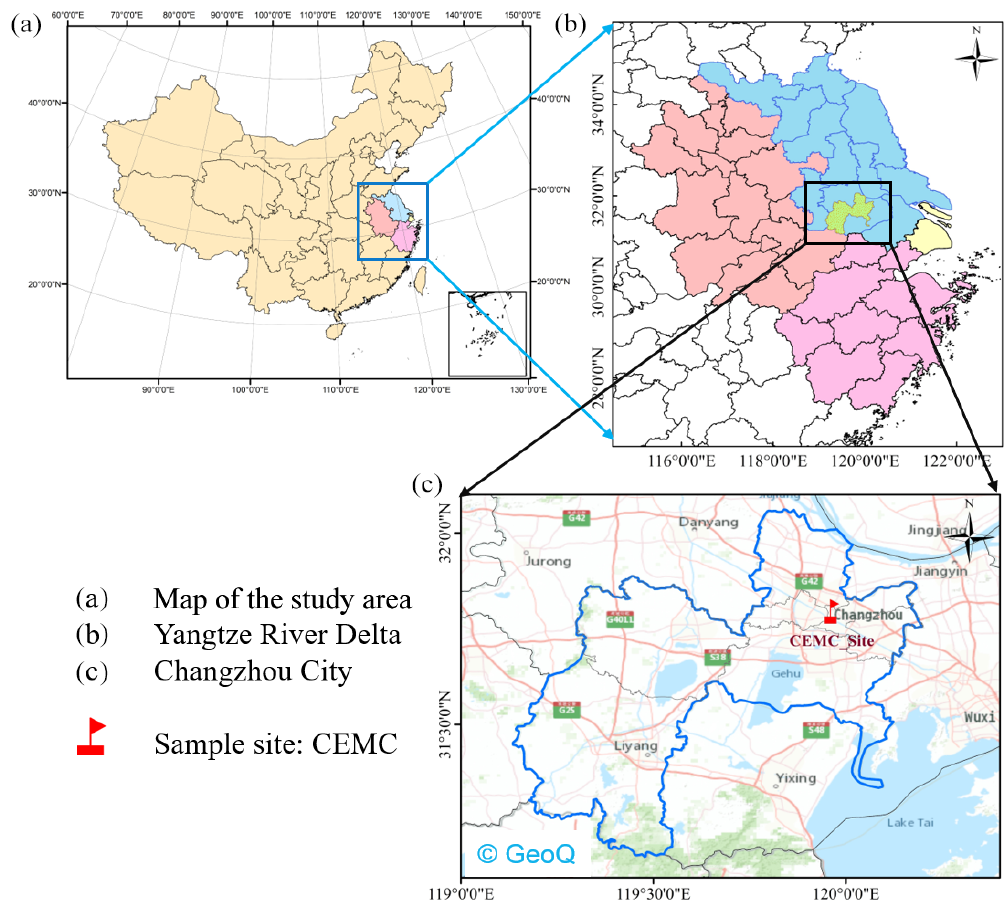
Figure 1. Location of the sampling site in Changzhou, China. Table 1. Statistics of hourly concentrations of organics associated with cooking emissions measured by TAG during the campaign.